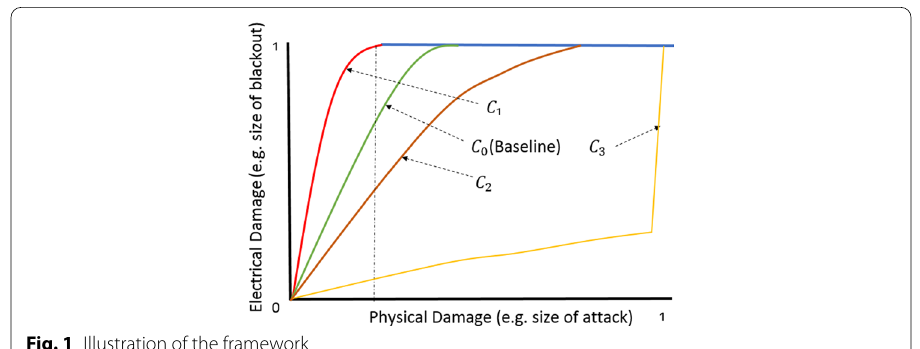
Fig. 1 Illustration of the